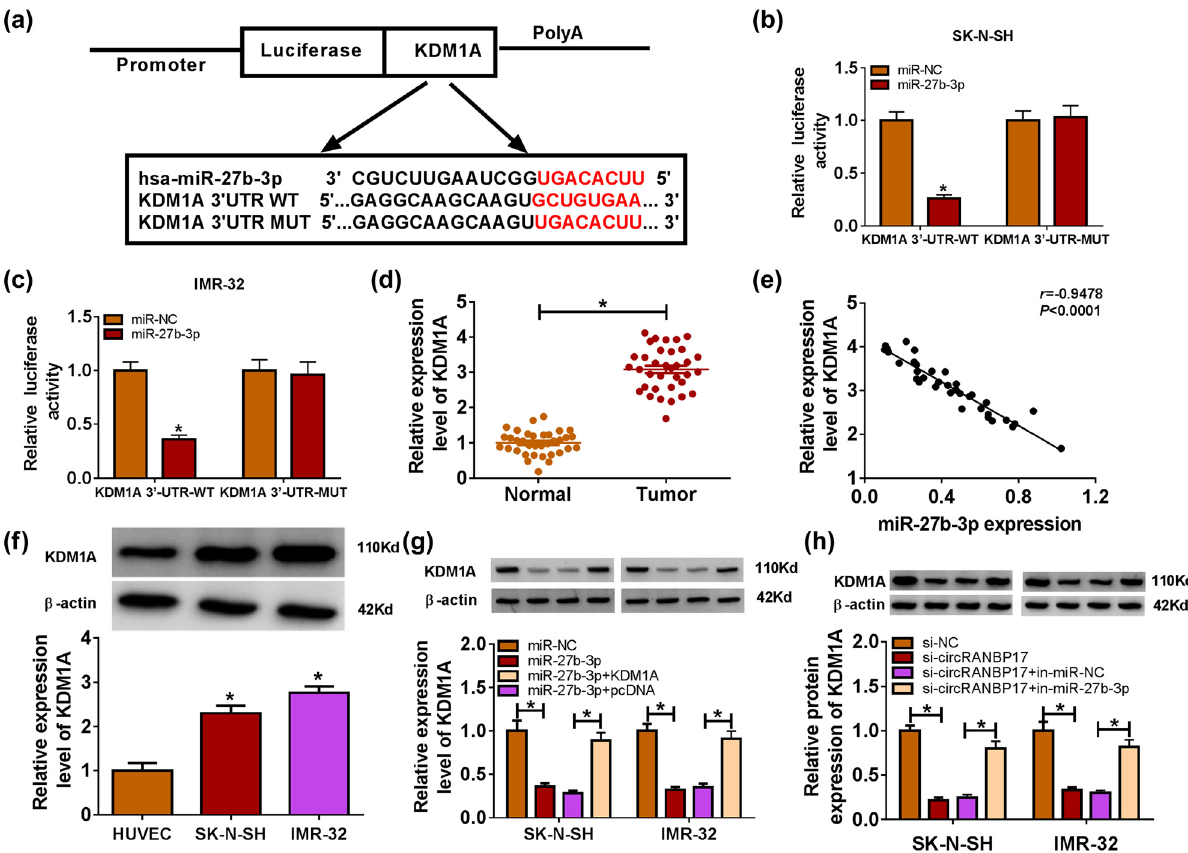
Figure 6: KDM1A negatively interacts with miR - 27b - 3p. ( a ) Complementary sequences between KDM1A 3 ′ - UTR and miR - 27b - 3p. The luci - ferase activities of KDM1A 3 ′ - UTR WT, KDM1A 3 ′ - UTR MUT reporter in SK - N - SH ( b ) and IMR - 32 ( c ) cells transfected with miR - 27b - 3p or miR - NC by dual luciferase reporter assay. The level of KDM1A in NB tissues ( d ) and cells ( f ) were detected by qRT - PCR. ( e ) Correlation between KDM1A and miR - 27b - 3p. ( g ) Protein level of KDM1A in SK - N - SH and IMR - 32 cells after miR - 27b - 3p and KDM1A overexpression were measured by western blot assay. The protein level of KDM1A in SK - N - SH and IMR - 32 cells transfected with si - circRANBP17, si - circRANBP17 + in - miR - 27b - 3p or their matched controls was detected by western blot ( h ) . * P <